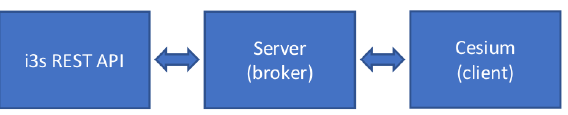
Figure 7. Rendering I3S in Cesium overview.